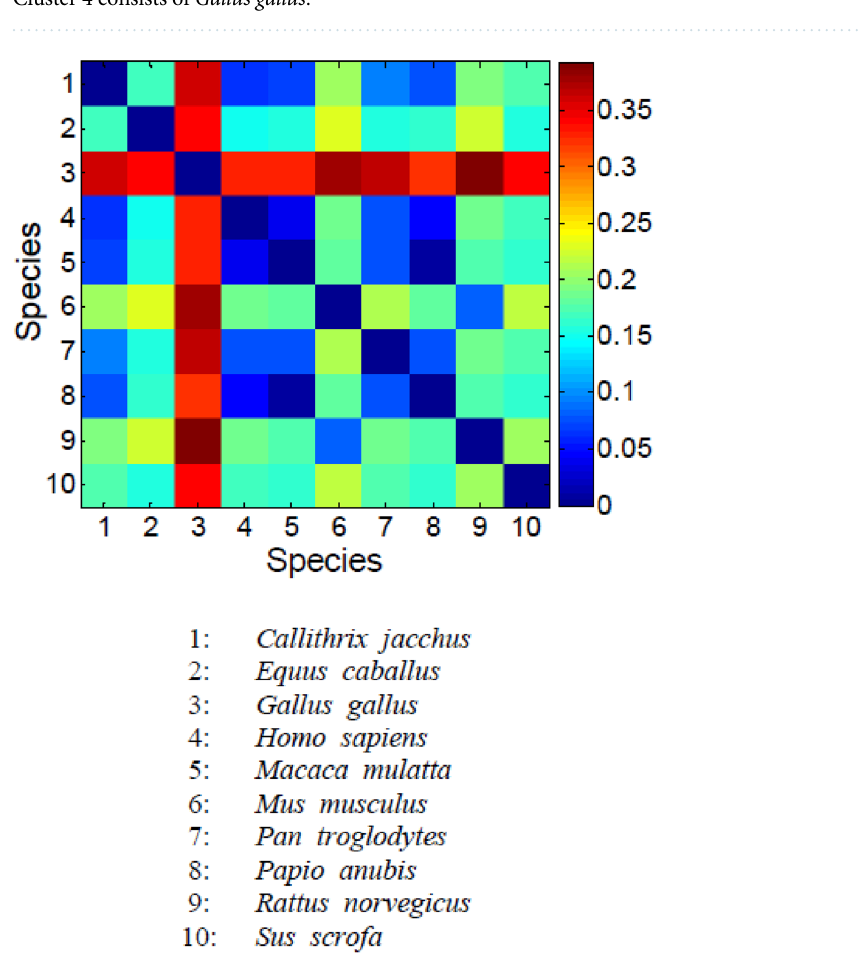
Figure 4. The dissimilarity matrix for beta HBB sequences derived from 10 organisms. The diagonal shows zero value, because diagonal element represents dissimilarity between an organism and organism